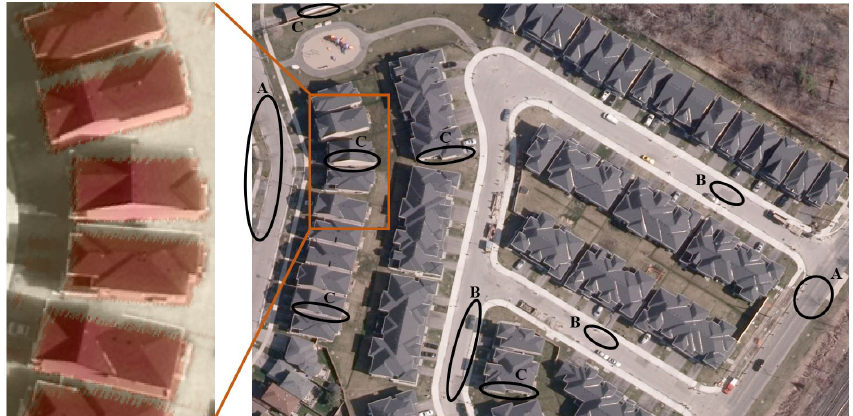
Figure 20. Examples of misclassification by external factors (A: different acquisition time, B: shadow, C: inexact orthorectifi- cation) on corresponding aerial photo: the zoom-in shows a height LiDAR-image overlay in transparent orange